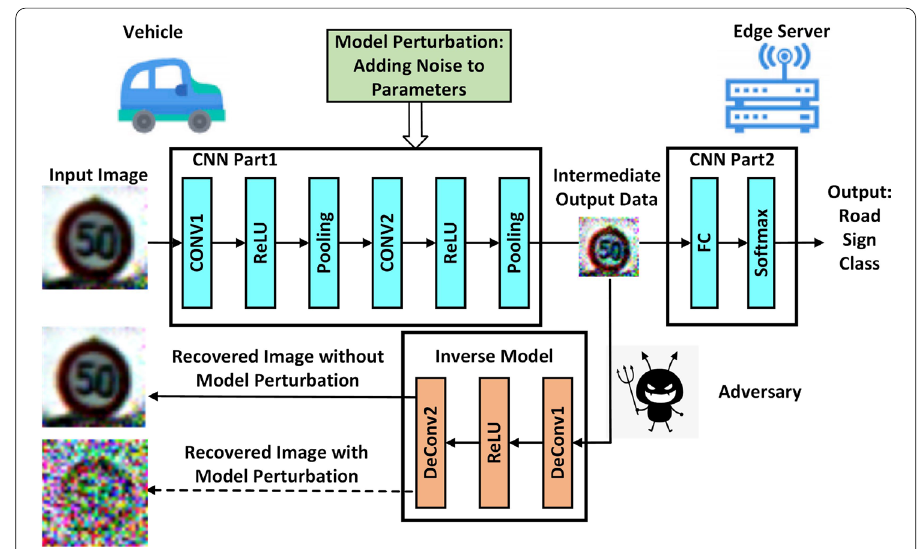
Fig. 2 Reconstruction attack and model perturbation defense for device-edge